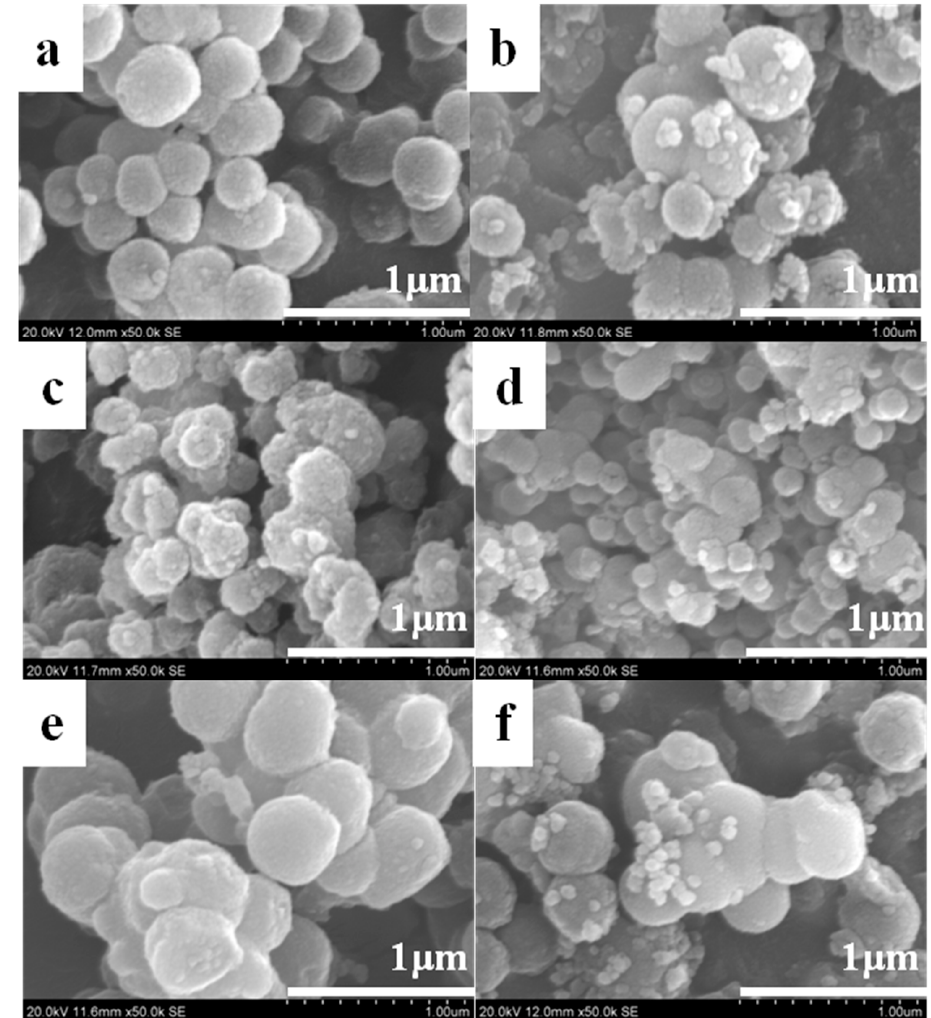
Figure 3. SEM micrographs of synthesized titania: ( a ) CS1 (before calcination); ( b ) CS1 (after calcination); ( c ) CS2 (before calcination); ( d ) CS2 (after calcination); ( e ) CS3 (before calcination); ( f ) CS3 (after calcination).